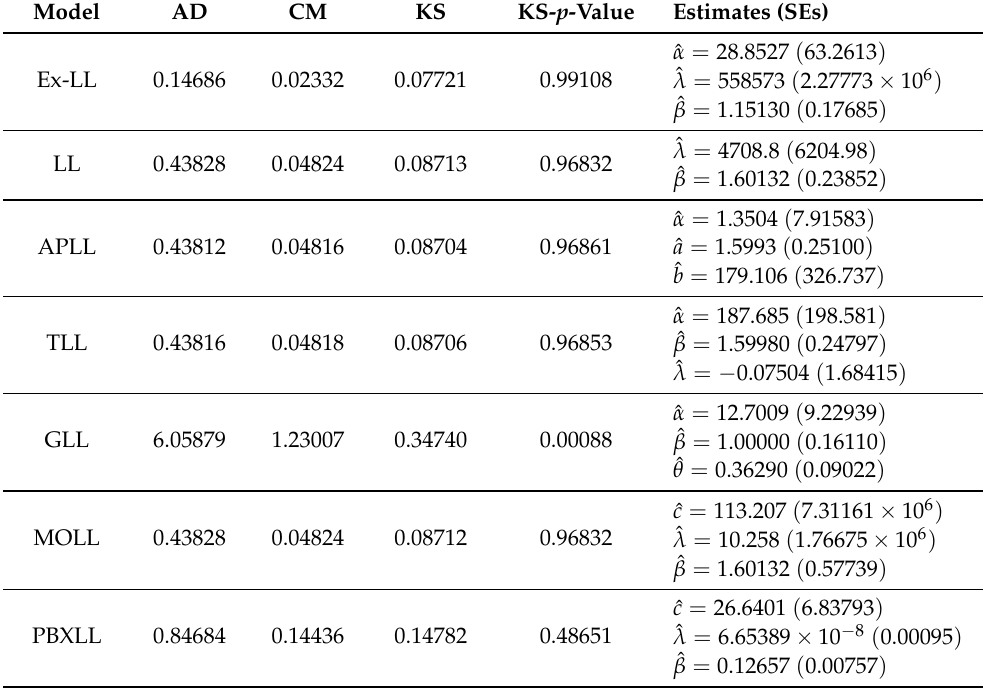
Figure 6. Histogram of data set II along with the fitted functions of the Ex-LL model. Table 15. Measures of goodness-of-fit and estimates of the Ex-LL distribution and other distributions for data set